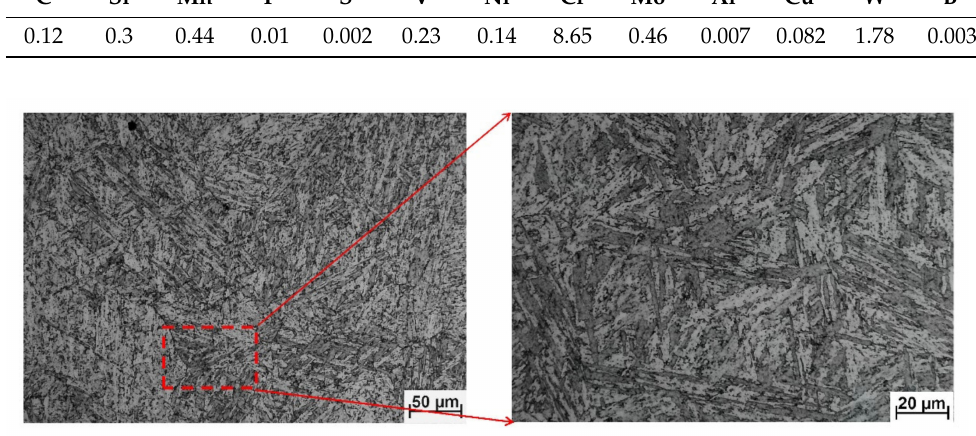
Figure 1. As-received micrograph of F92